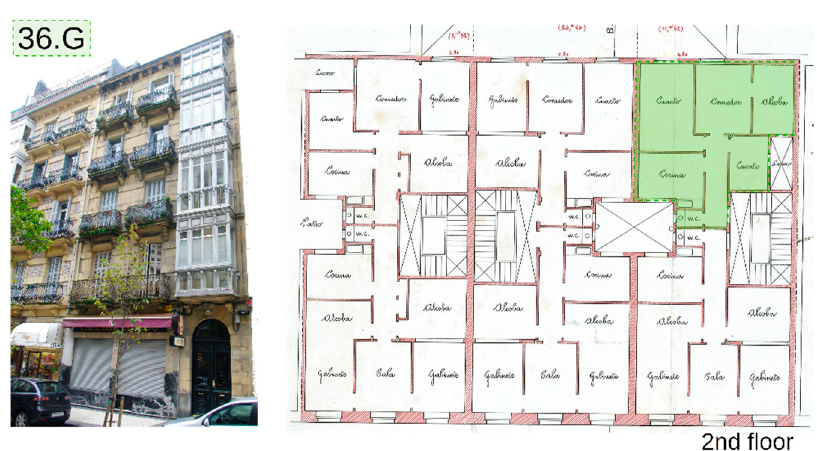
Figure A7. Floor plans of the blower door tests performed in the Larramendi 13 case study.